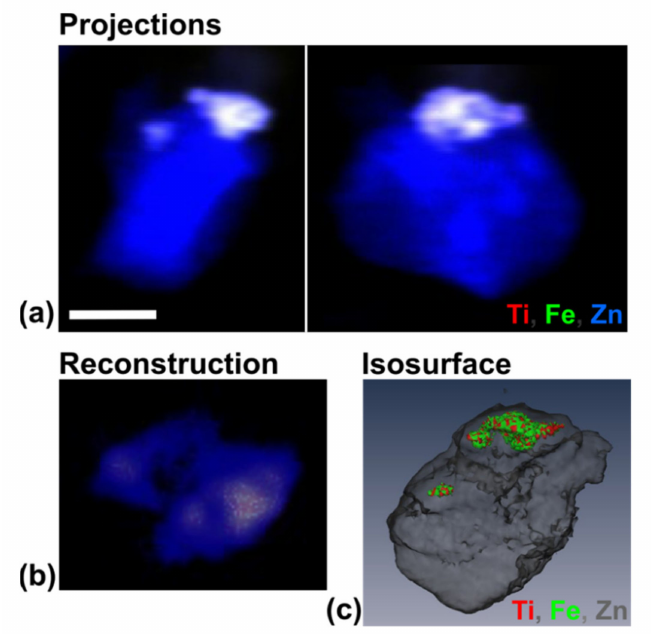
Figure 10. XRF tomography of a single cell performed at the BNP. ( a ) 2D projections of the cell from two different rotation angles, showing the overlay of the cell (represented by Zn in blue) and the nanocomposites (represented by Ti in red and Fe in green; consequently, nanocomposite rich region appears white); ( b ) a single reconstructed cross section showing the overlay of Ti, Fe, and Zn; ( c ) Isosurface of reconstructed 3D volume of the cell (Zn in gray) with the nanocomposites (Ti in red and Zn in green) inside. For the rotation movie of this sample, see Video S1: innerTomo. The scale bar is 5 µ